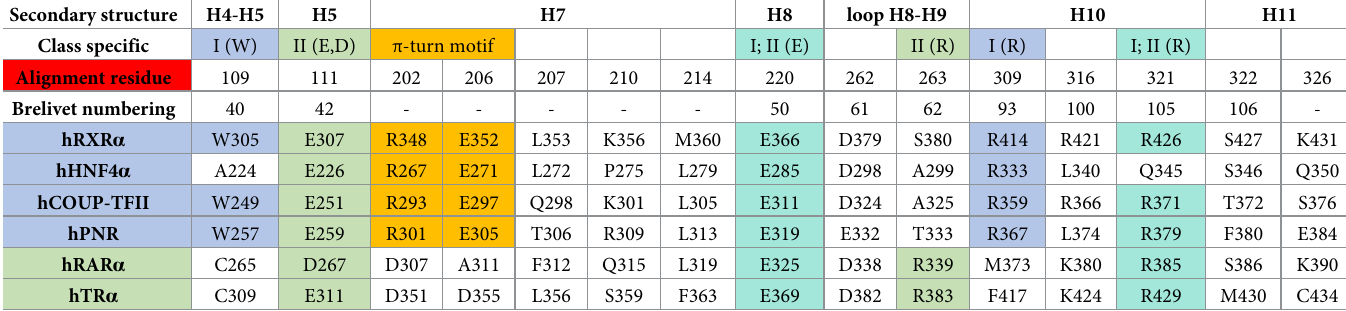
Table 1. Amino acid residue mapping for nuclear receptors considered in this study. H stands for helices. ‘Alignment residue’ is the generic numbering used in this study (S1 Fig). The class specific residues are specified by I and II for class I and class II NRs, respectively, with boxes colored in blue and green, respectively, or in cyan for residues common to class I and class II, together with the corresponding residue number [17]. The H7 column with yellow boxes refers to residues of the π -turn, further highlighting the differential conservation of the